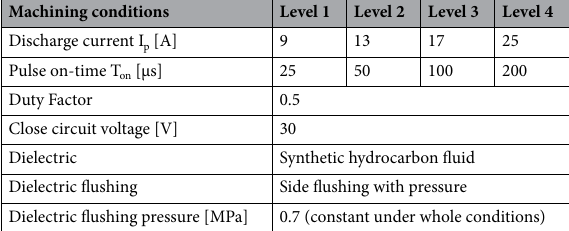
Table 2. Experimental parameters.